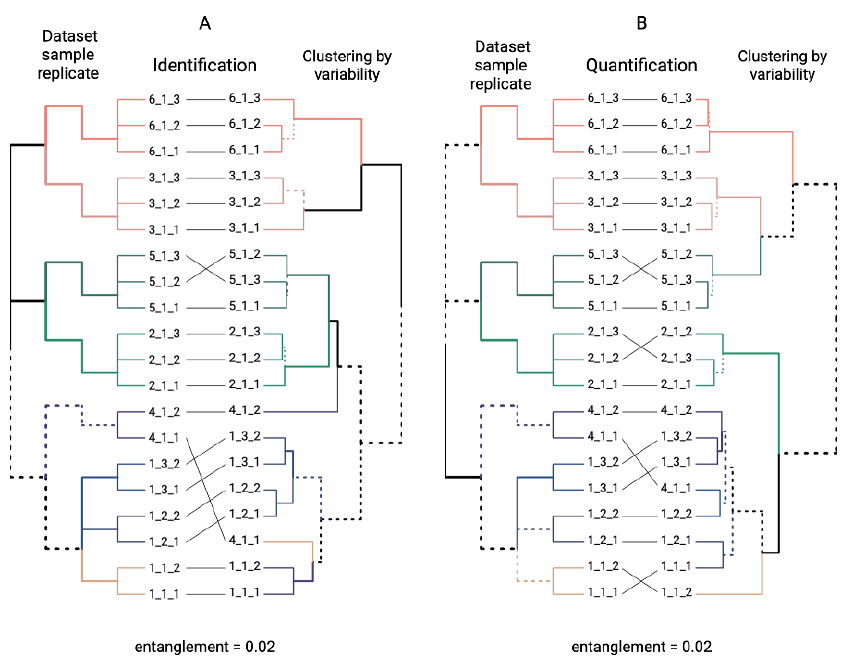
Figure 4. Tanglegrams comparing manually set initial “Dataset_Sample_Replicate” distribution and hierarchical clustering tree of variability measurements. Hierarchical clustering was performed by variability values for successful identification ( A ) and reliable quantification ( B ) protein lists. Individual clusters are set in different colors. Branches, which differ between two trees, are given as dashed